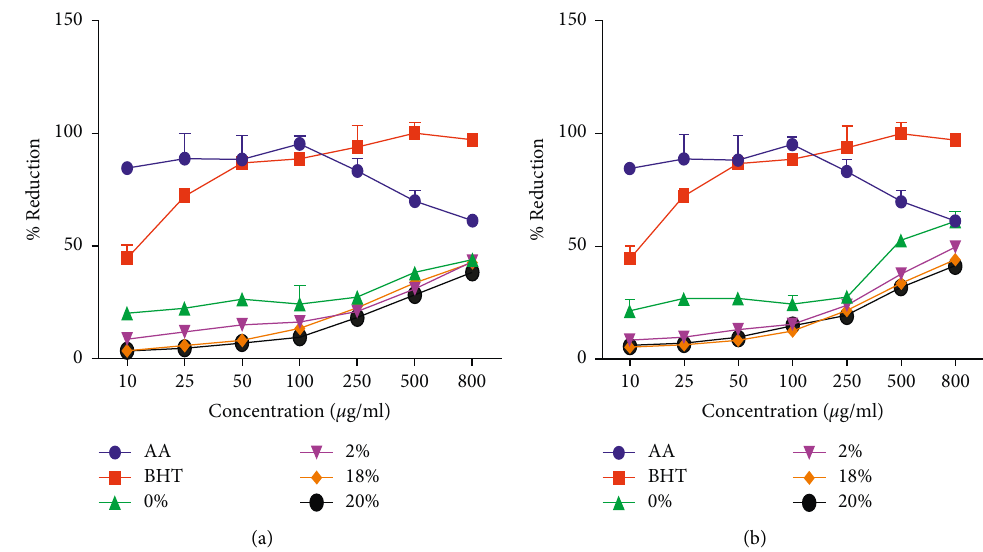
Figure 2: The Reducing power of P . ostreatus mushroom grown on various supplemented substrates: (a) sugarcane bagasse base substrates supplemented with different levels of wheat bran); (b) sugar cane tops base substrates supplemented with different levels of wheat bran).